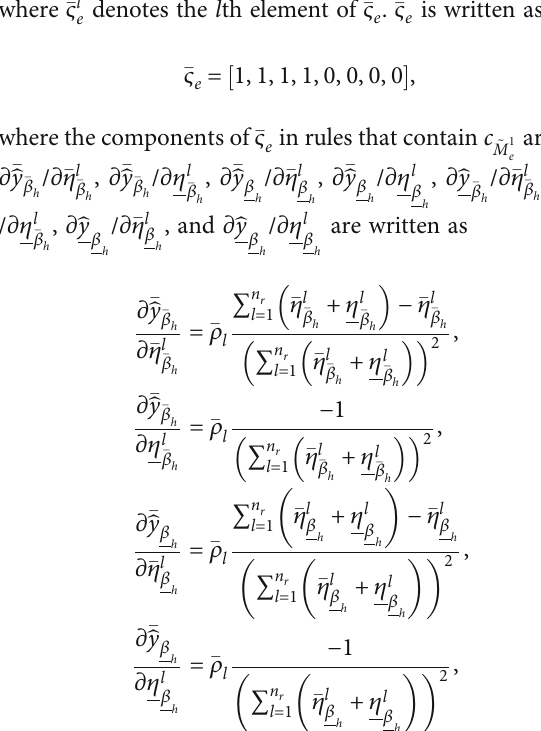
Figure 8: Scenario 2: multiple load